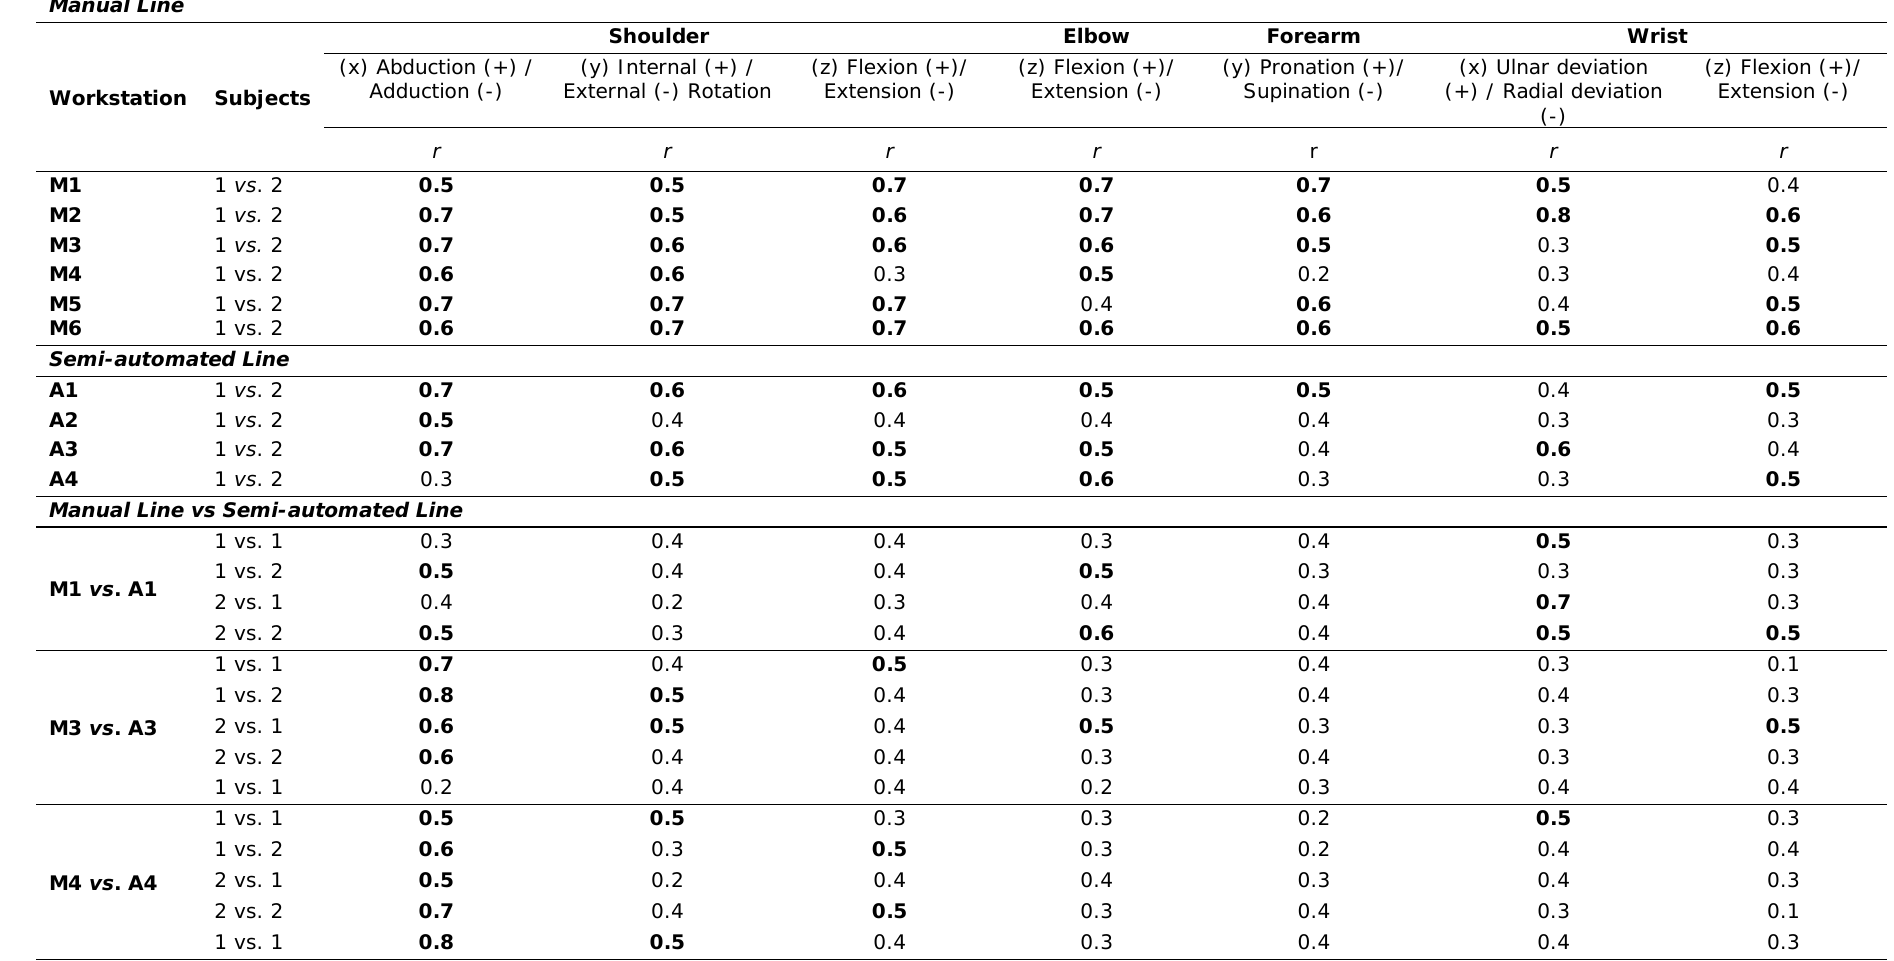
Table 4. Coefficients of cross correlation of the upper-limb joints